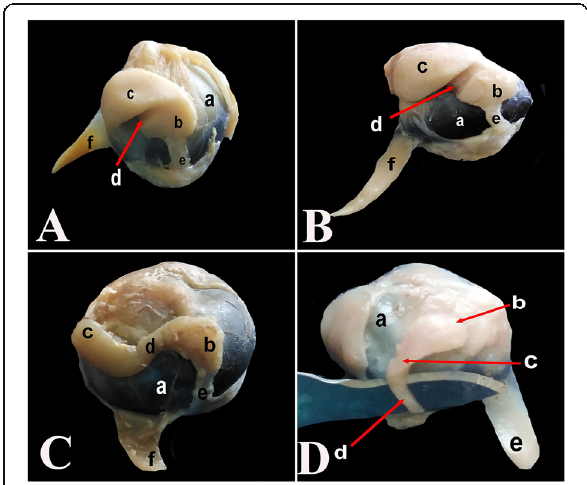
Fig. 2 A photomacrograph of the eye showing anatomical dissection of the HG, eyeball ( a ), anterior extremity ( b ), posterior extremity ( c ), middle groove ( d ), excretory duct ( e ), and extraocular muscle (pyramidalis oculi) ( f ) in duck ( A ), goose ( b ), ibis ( c ), and pigeon ( d )